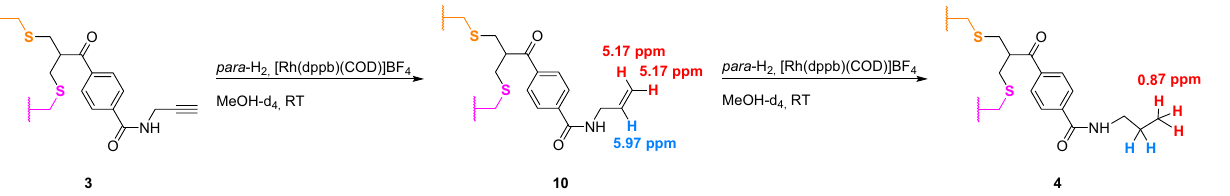
Scheme 4. Hydrogenation of the triple bond containing PHIP-label inserted in the disulfide bridge of eptifibatide 3 with para -H 2